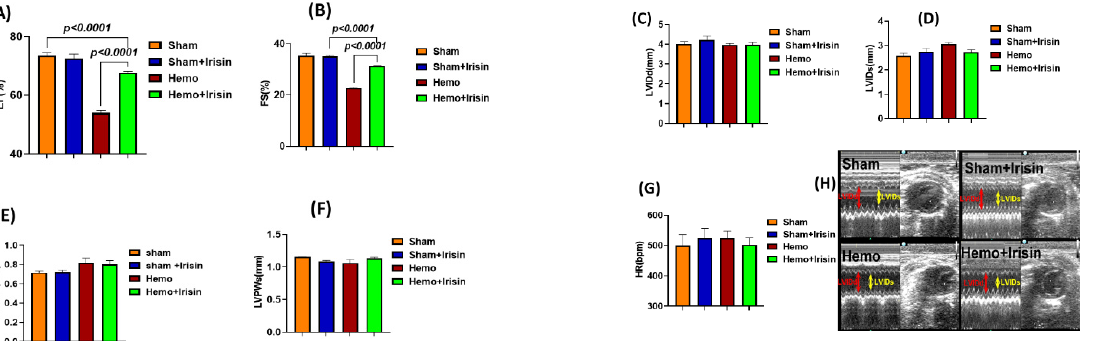
Figure 2. Echocardiographic measurements of cardiac function in hemorrhagic mice; Left ventricular (LV) function was assessed by two-dimensional M-mode echocardiography in sham and hemorrhage groups 2 h after sham operation and resuscitation. Bar graphs for ( A ) Ejection Fraction (EF); ( B ) Fractional Shortening (FS); ( C ) LV Internal Dimension in diastole (LVIDd); ( D ) LV Internal Dimension in systole LVIDs; ( E ) Left Ventricular Posterior Wall in diastole (LVPWd); ( F ) LV Posterior Wall in systole (LVPWs); and ( G ) Heart Rate (HR); ( H ) A representative image for the two dimensional and M-mode (Data are shown as Mean ± SEM, n = 4/each group).